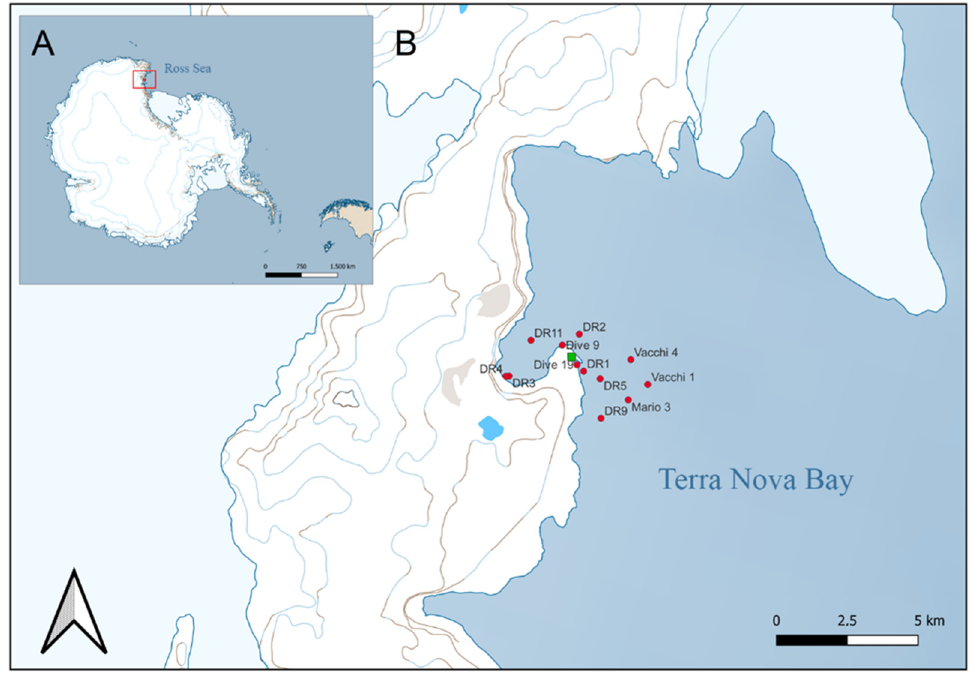
Figure 1. Antarctica ( A ) with detail of Terra Nova Bay (Ross Sea) and ( B ) sampling sites with Mario Zucchelli Station (Italy) highlighted in green.